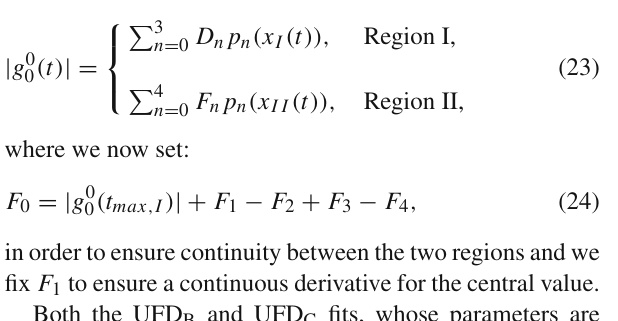
Table 4 Parameters of the UFD B and CFD B fits to | g 0